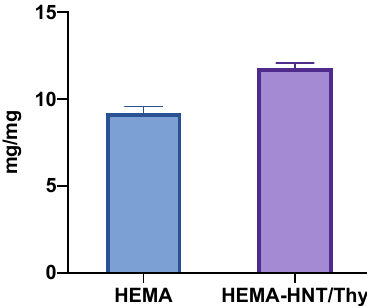
Figure 2. Swelling capacity of HEMA and HEMA-HNT/Thy cryogels.